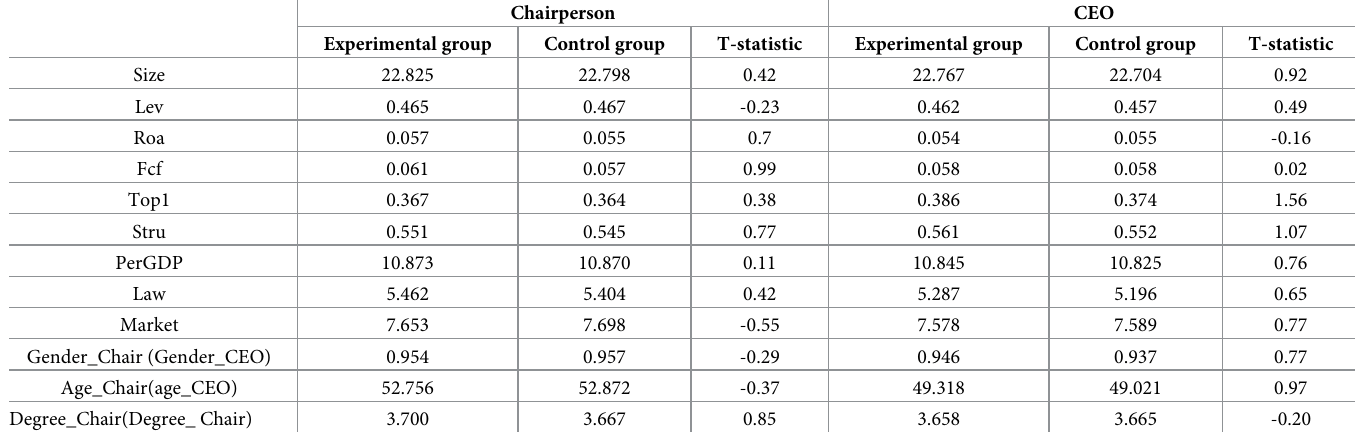
Table 4. T test for the experimental group and control